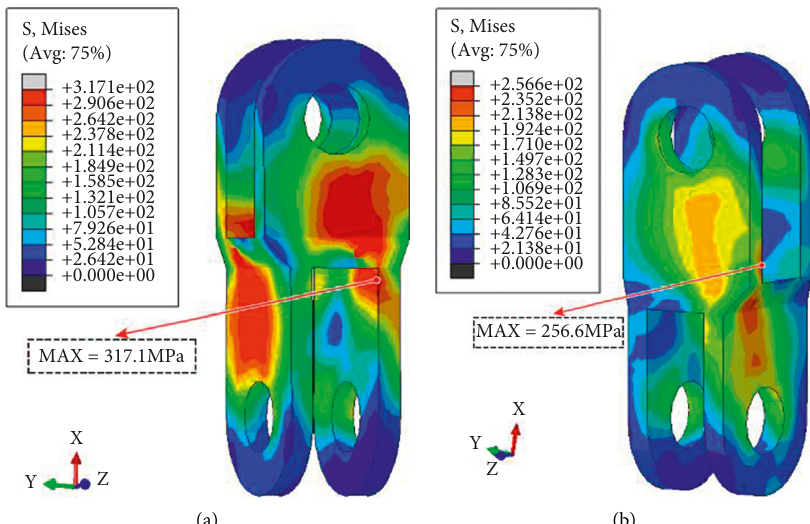
Figure 34: Stress cloud picture of rectangular hanging plate: (a) connected with the iced conductor; (b) connected with the ice-shedding conductor.